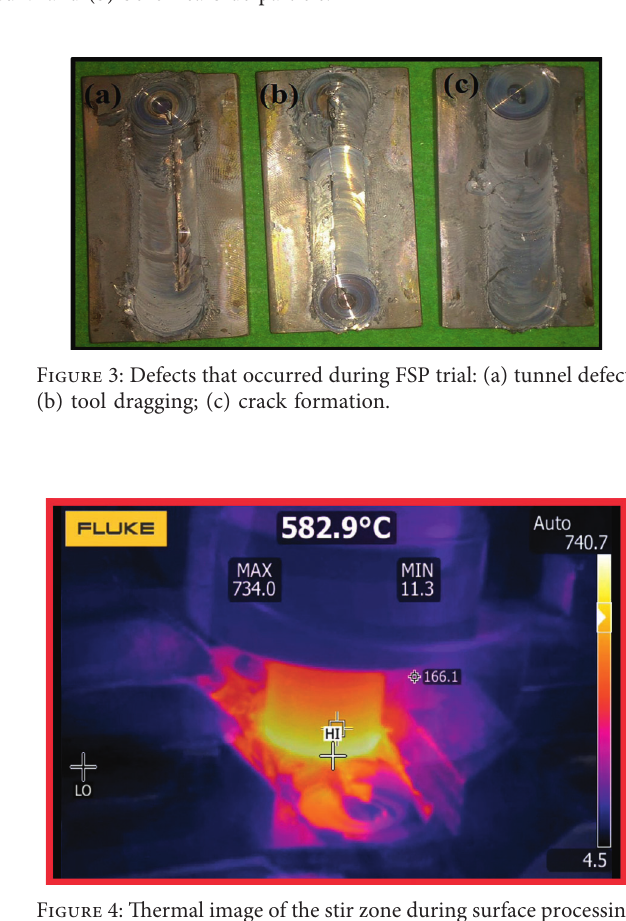
Figure 1: FESEM image of (a) CuNi and (b) boron carbide particle.